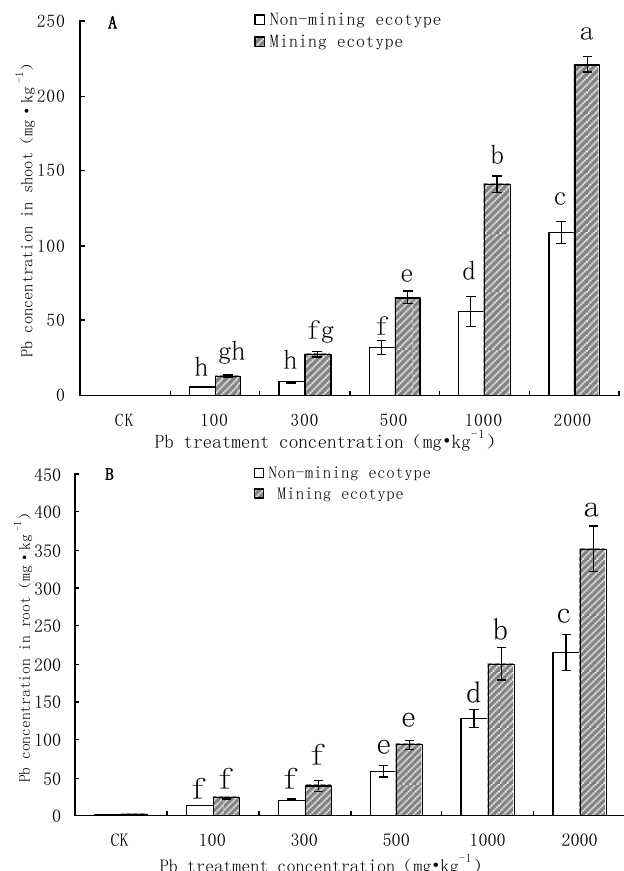
Figure 2. Pb concentrations in root and shoot of two ecotypes of M. floridulus under different Pb treatment (( A ) in shoot, ( B ) in root). Note: Error bars indicate standard deviation; Different letters in the same group indicate significant difference at p < 0.05 according to Duncan’s multiple range tests; the same below